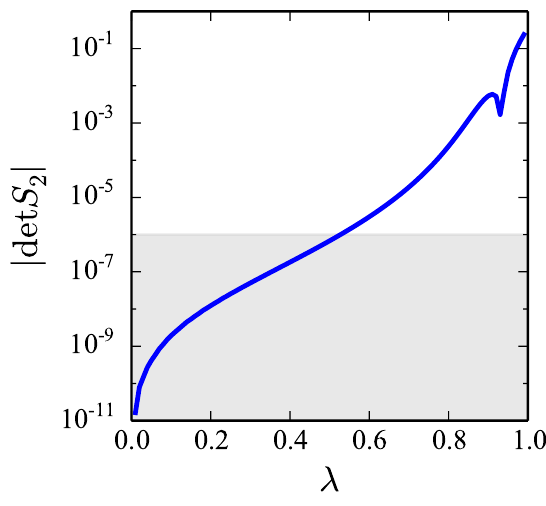
Figure 3: The determinant of the S shows the region that in which det S